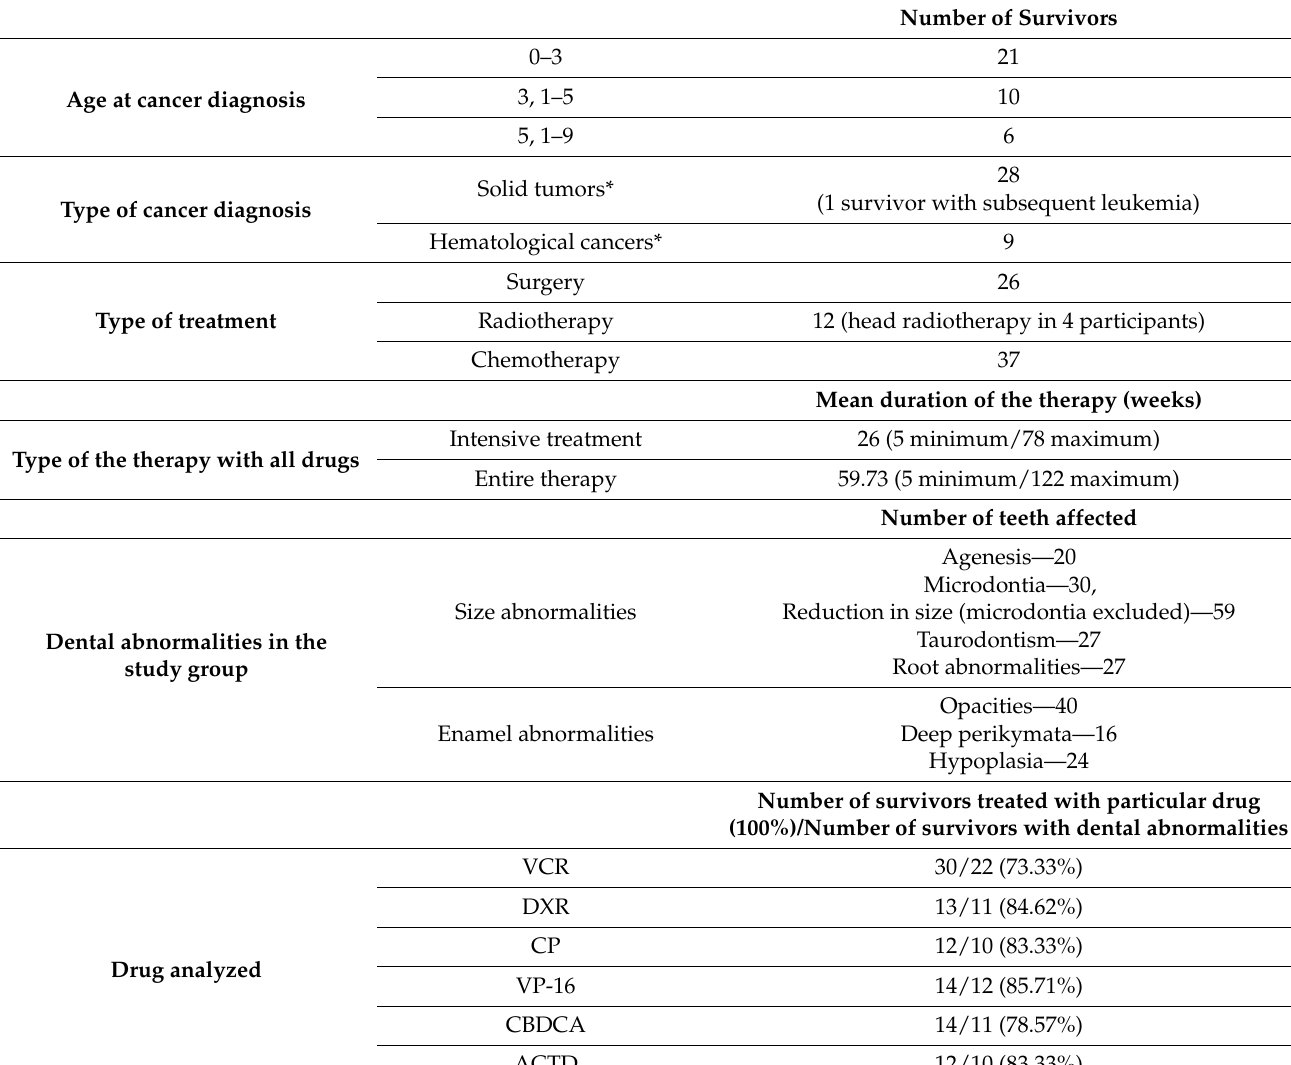
Table 1. Baseline characteristics of the study